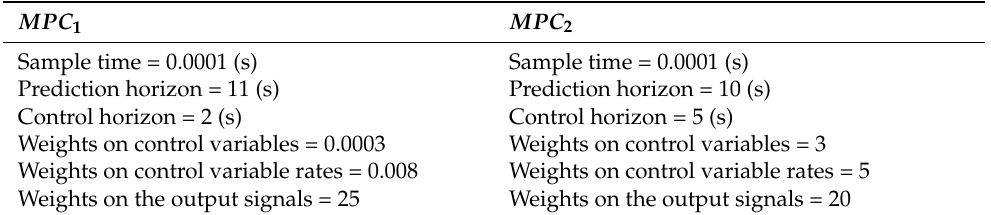
Table 2. Design parameters of the two decentralized controllers, MPC 1 and MPC 2 , for the two subsys- tems.